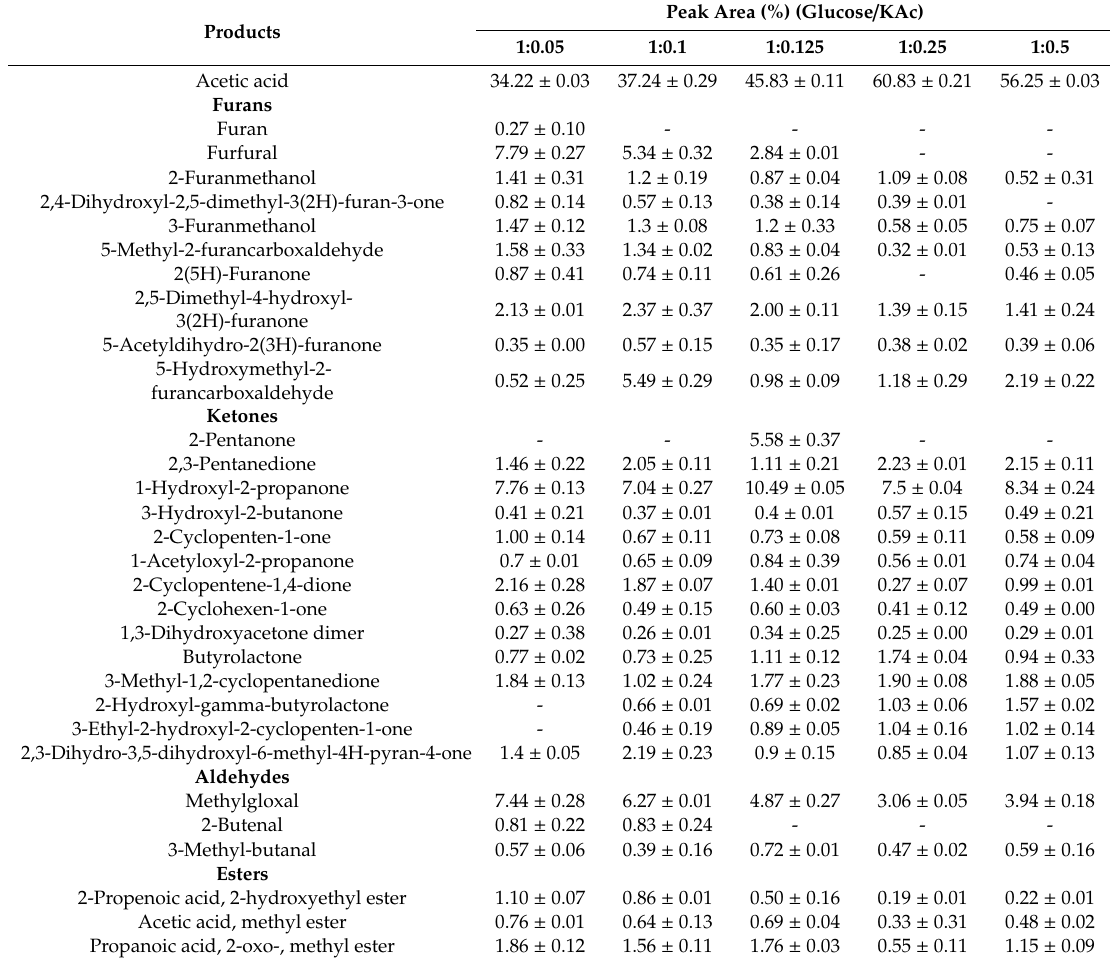
Table 4. Peak area (%) of the typical products derived from the glucose in situ catalytic pyrolysis at 350 ◦ C with the di ff erent glucose / KAc ratios.